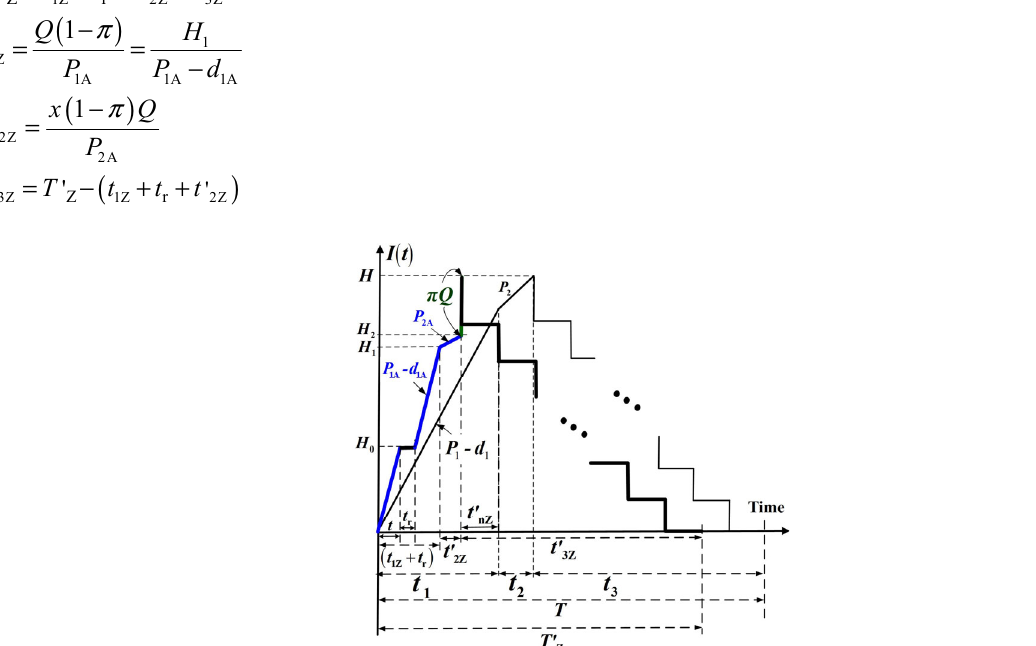
Fig. 1. Situation one’s stock level of our proposed system (in thicker lines) compared to a model with rework only (in thinner lines)